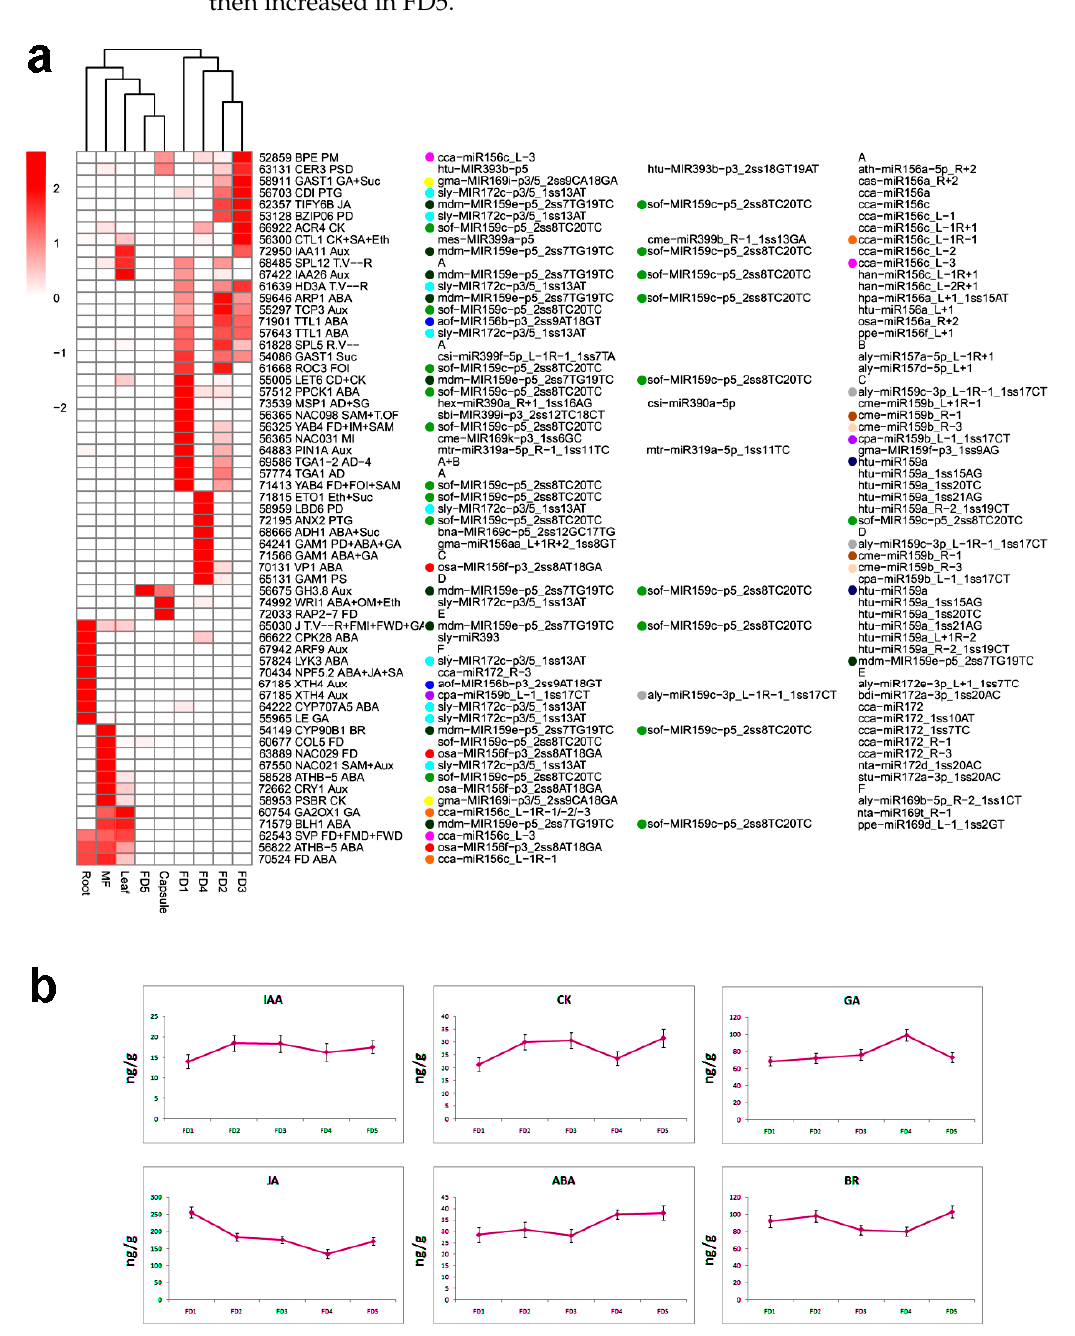
Figure 4. Tissue-specific expression of miRNA targets and hormone concentrations. ( a ) clustering of miRNA targets with their maximum expressions to a particular tissue type. Colored circles show the occurrence of same miRNA for multiple targets (row names show the gene ID, common name and biological process abbreviation, the full abbreviation can be seen in the legend of Figure 3c) (some genes have multiple targets, which are placed separate under headings A-F); ( b ) relative concentrations of different plant hormones in five stages of flower development.